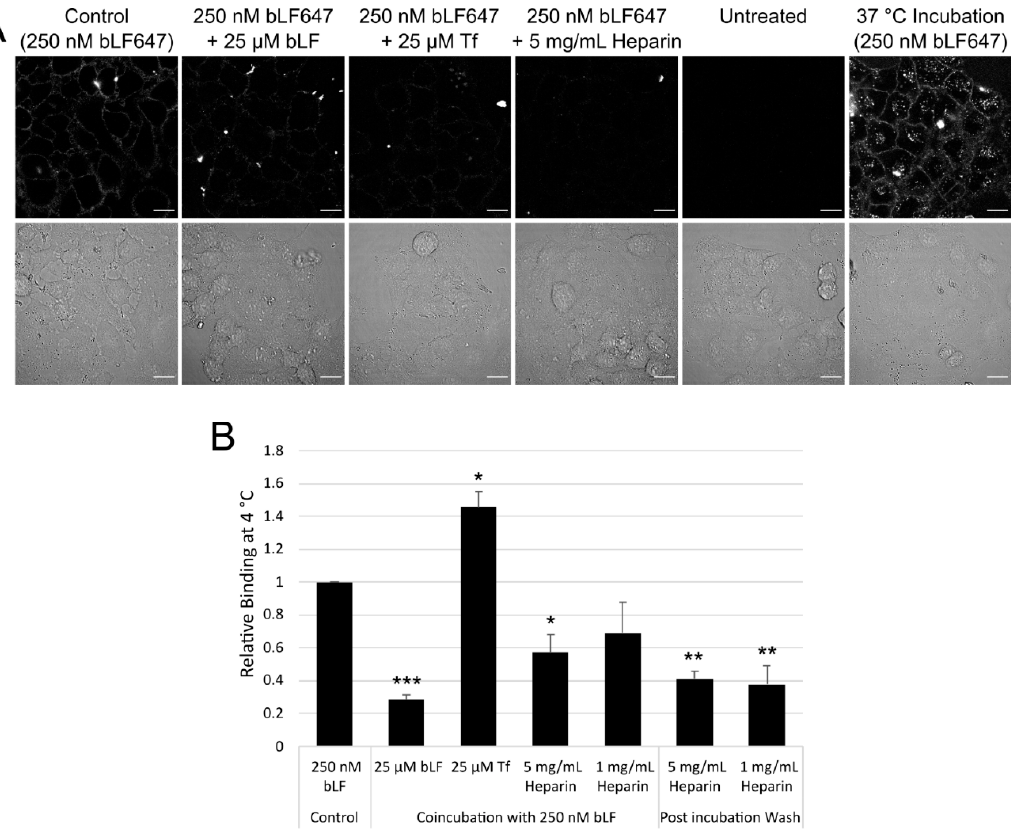
Figure 2. bLF cell binding and competition. Cells were incubated with 250 nM bLF647 in the presence of potential competitors for 1 h at 4 °C before being analysed by confocal microscopy ( A ) or flow cytometry ( B ). Scale bar = 50 µm, error bars represent SEM. Flow cytometry represents the mean of three independent experiments performed in duplicate; fluorescence intensity is measured using the median and normalised to the control. Statistical analysis was performed using a one-way ANOVA (F (6, 14) = 17.13, p < 0.0001) with a Dunnett post hoc analysis of control versus samples * p < 0.05, ** p < 0.01, *** p < 0.001.